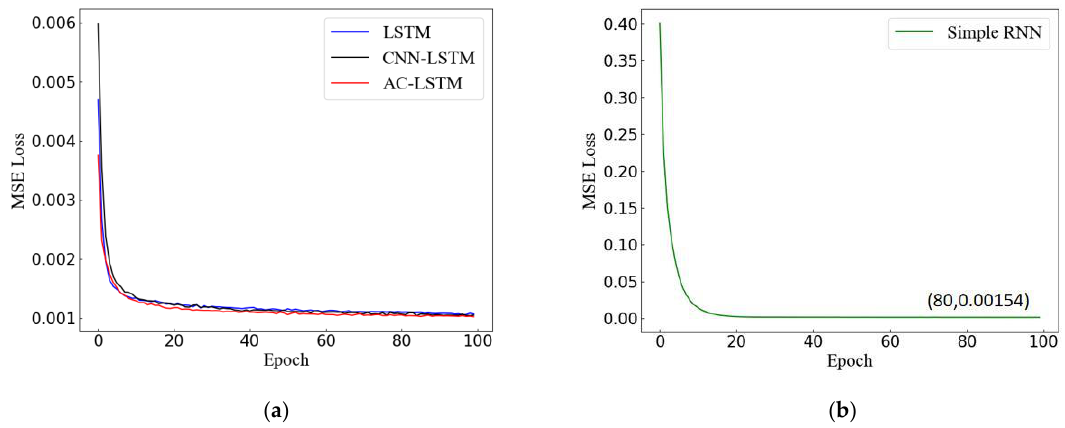
Figure 8. The loss convergence of deep learning methods in one-hour PM 2.5 prediction: ( a ) loss